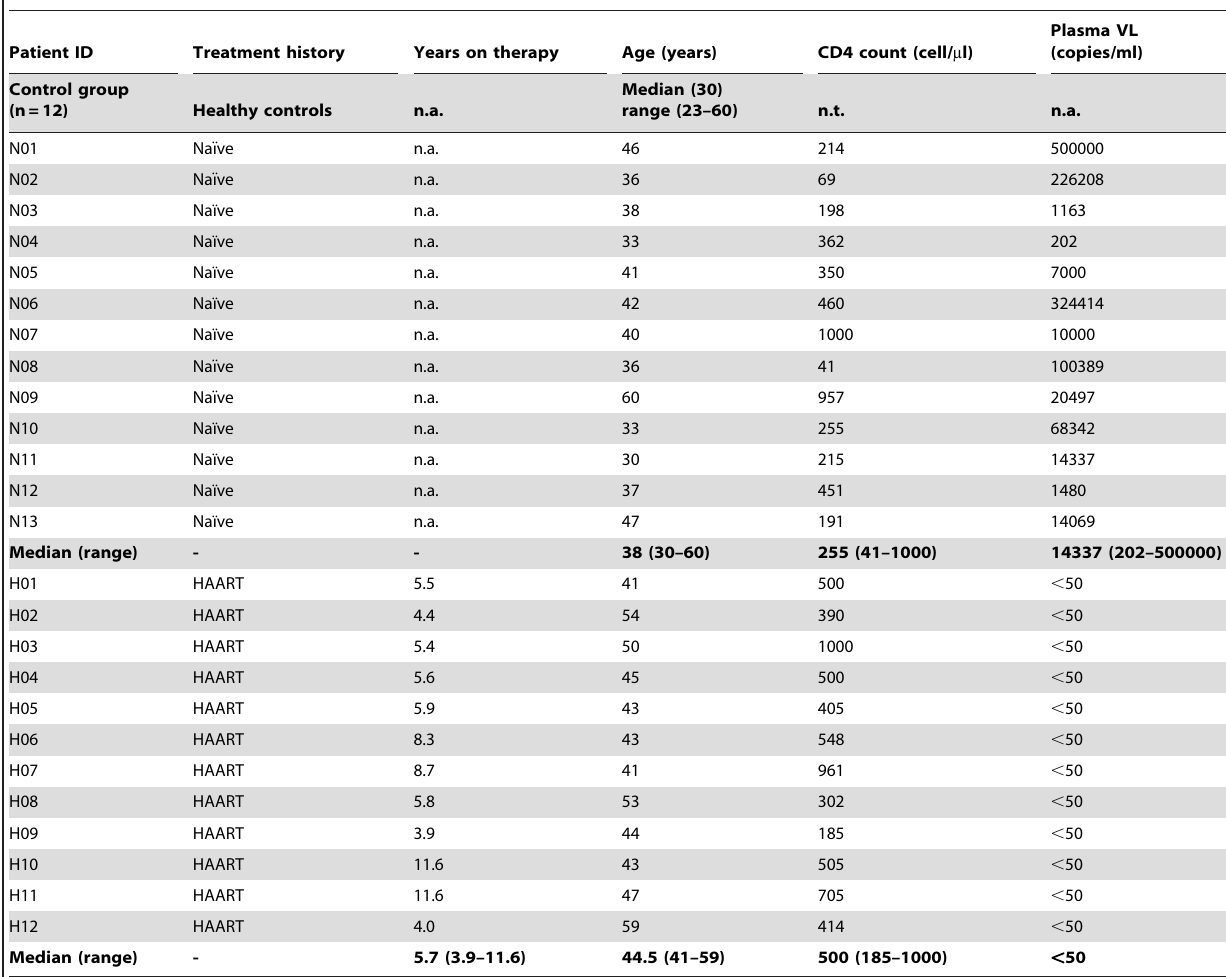
Table 1. Clinical characteristics of HIV-1 patient